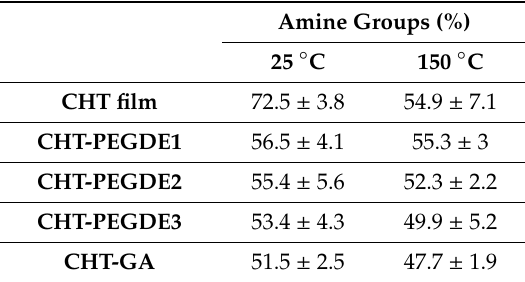
Table 1. Percentage of amine groups in chitosan and crosslinked chitosan films, dried at 25 ◦ C and with additional drying at 150 ◦